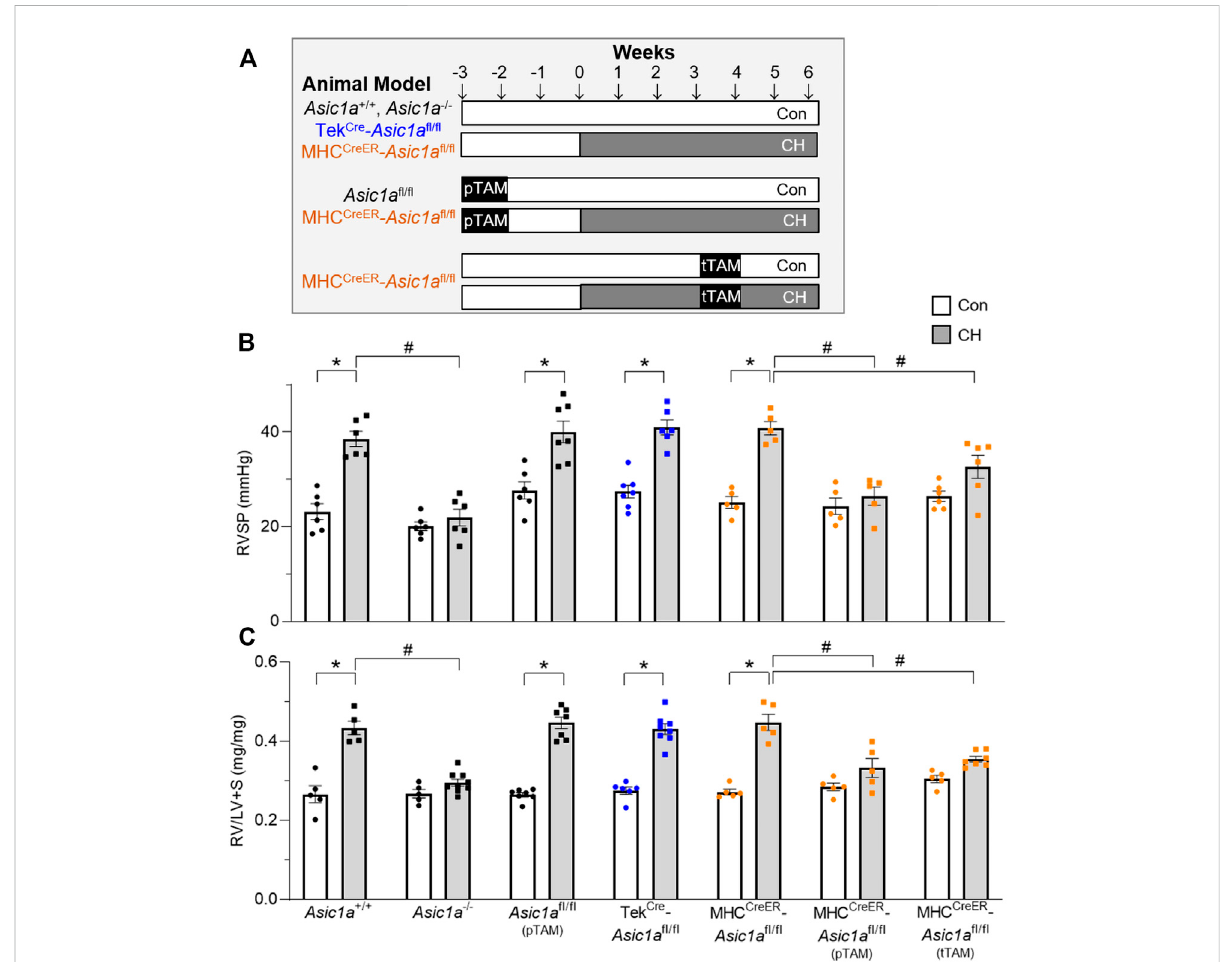
FIGURE 4 SM-speci fi c knockout of Asic1a protects against development of pulmonary hypertension and reverses established hypoxic pulmonary hypertension. (A) Experimental design showing treatments of no TAM, preventative (pTAM, administered before CH), and therapeutic (tTAM, administered following established pulmonary hypertension). (B) Right ventricular systolic pressure (RVSP, mmHg) and (C) Fulton ’ sIndex (RV/LV + S) in Asic1a +/+ , Asic1a − /- , Asic1a fl / fl (pTAM) , TekCre- Asic1a fl / fl , MHC CreER - Asic1a fl / fl , MHC CreER - Asic1a fl / fl (pTAM) , or MHC CreER - Asic1a fl / fl (tTAM) mice under control conditions (white bars, circles) or following 6 weeks CH (grey bars, squares). SM- Asic1a knockout was induced by treatment with tamoxifen as a preventive (pTAM; before exposure to CH) or therapeutic approach (tTAM; following establishment of CH-induced pulmonary hypertension). n = 5-8/group; analyzed by two-way ANOVA. Signi fi cant interactions between the individual groups ( p < 0.0001 for both RVSP and RV/LV + S) were compared with Š ídák ’ s multiple comparisons tests; * p < 0.05 vs. control; # p < 0.05 vs. respective genetic control.